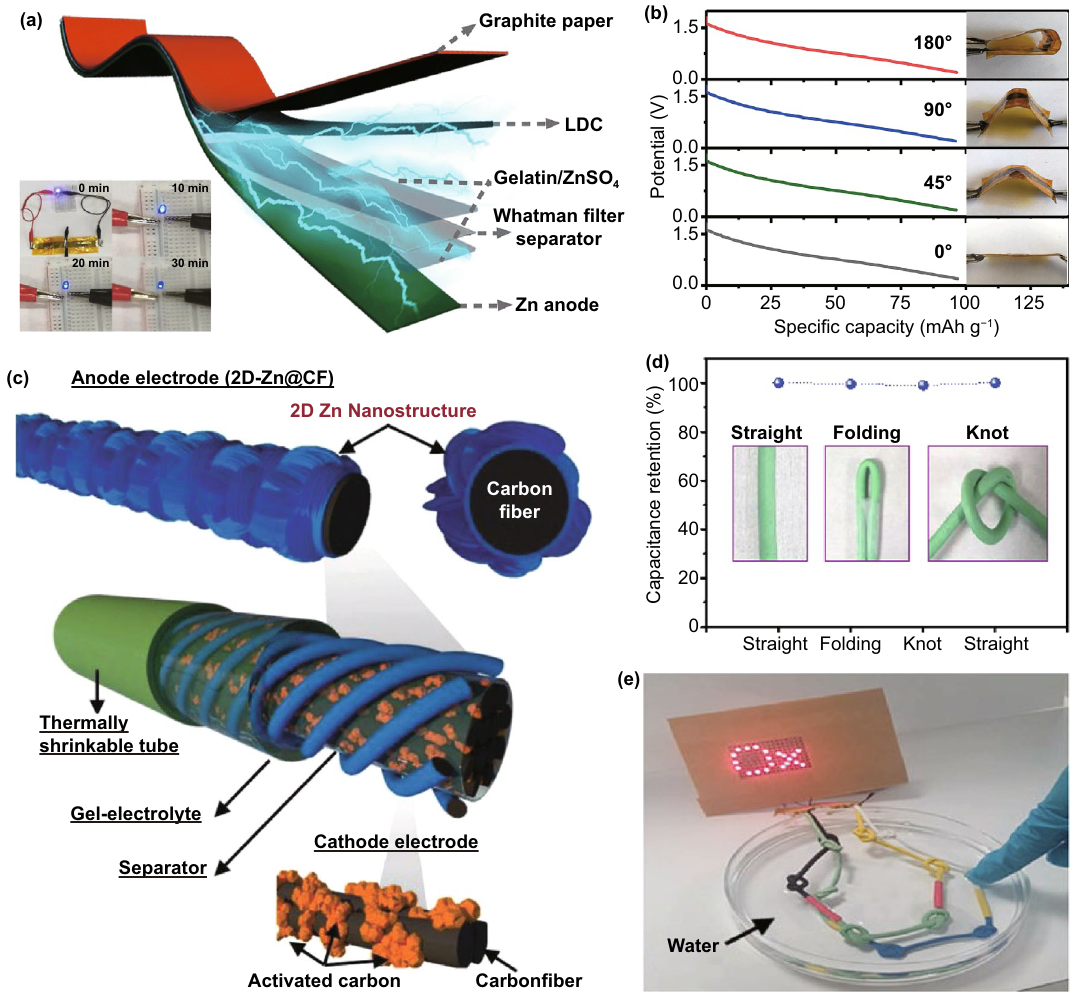
Fig. 13 a Schematics of sheet‑type flexible ZHSCs. b Discharge curves under different deformation conditions. Reproduced with permission from Ref. [83]. Copyright 2019, Elsevier. c Schematic of fiber‑type flexible ZHSCs. d Capacity retention under the condition of straight, folded and knotted. e LED powered by connected fiber‑type ZHSCs in water. Reproduced with permission from Ref. [53]. Copyright 2020, Wiley–